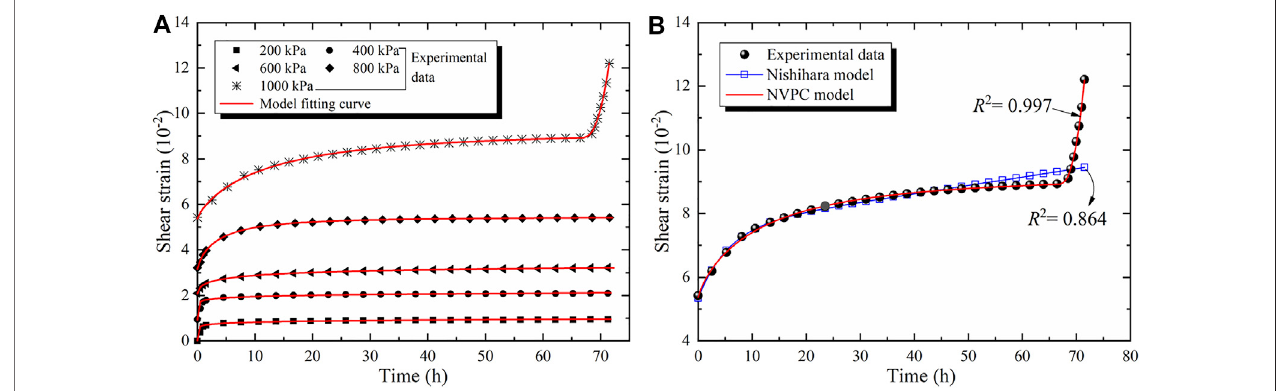
FIGURE 12 | Comparison between the theoretical results and the experimental data (A) and (B)